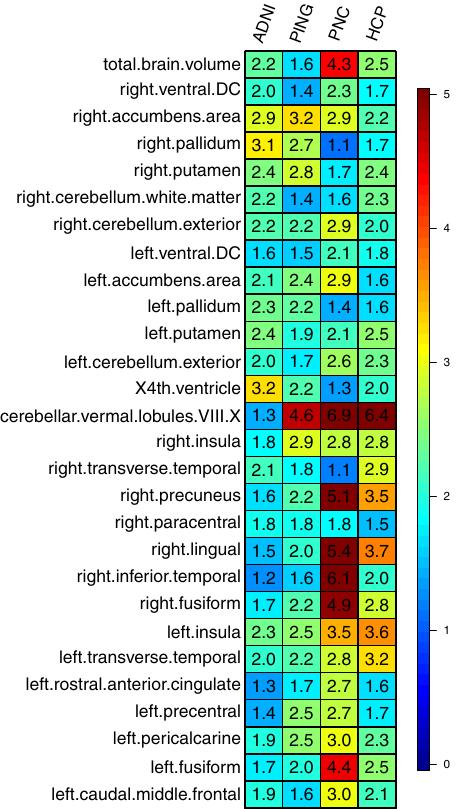
right.lingual left.caudal.middle.frontalleft.fusiformleft.pericalcarineleft.precentralleft.rostral.anterior.cingulateleft.transverse.temporalleft.insularight.fusiformright.inferior.temporal Fig. 4 Prediction accuracy (incremental R 2 ) of gene-based polygenic risk scores constructed by UKB TWAS results ( n = 19,629 subjects) on the four independent data sets. The x axis lists the four independent cohorts (ADNI, HCP, PING, and PNC) and the y axis lists the ROI volumes. The displayed numbers are the proportions of phenotypic variation that can be additionally explained by UKB TWAS-derived gene-based